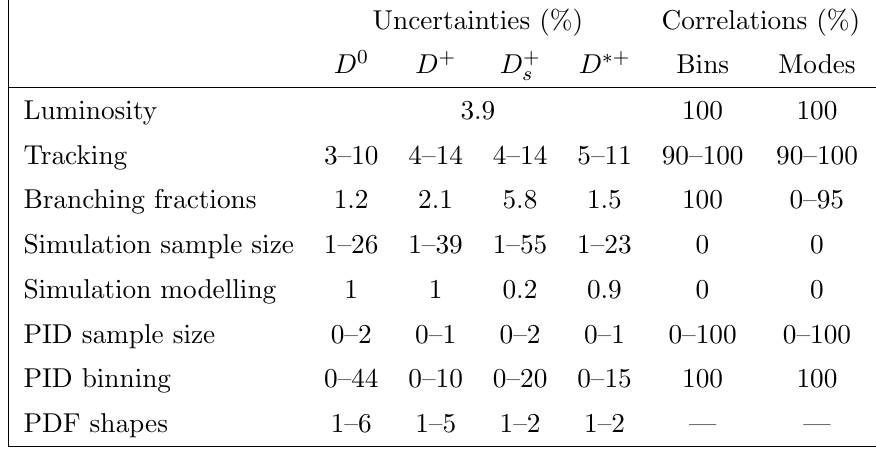
Table 2. Systematic uncertainties expressed as fractions of the cross-section measurements, in percent. Uncertainties that are computed bin-by-bin are expressed as ranges giving the minimum to maximum values. Ranges for the correlations between p T - y bins and between modes are also given, expressed in percent.